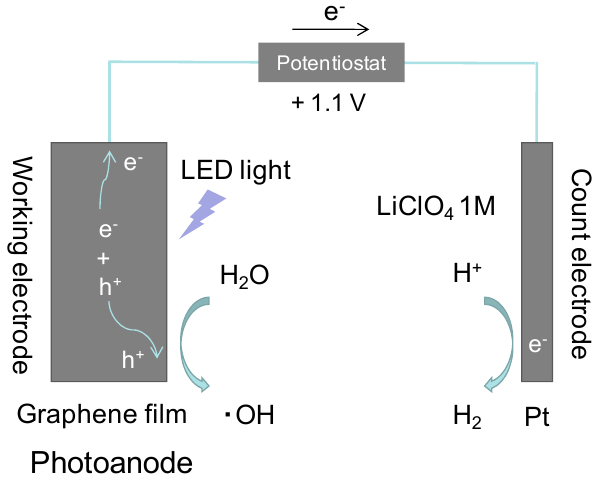
Figure 8. H 2 evolution obtained in darkness or under LED illumination using the electrodes made of (N)G or G film prepared at 900 or 1100 °C under Ar or Ar/H 2 flow: ( ) (N)G, 900 °C, Ar, Light; ( ) (N)G, 1100 °C, Ar/H 2 , Light; ( ) G, 900 °C, Ar, Light; ( ● ) G, 1100 °C, Ar/H 2 , Dark; ( ▲ ) G, 900 °C, Ar/H 2 , Light; ( ) G, 1100 °C, Ar/H 2 , Light.